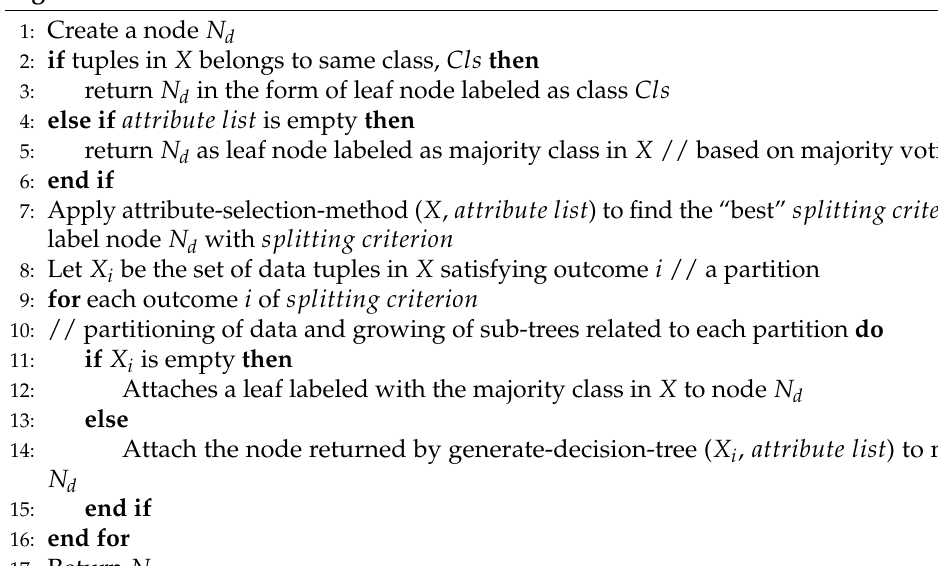
Algorithm 2 Decision Tree